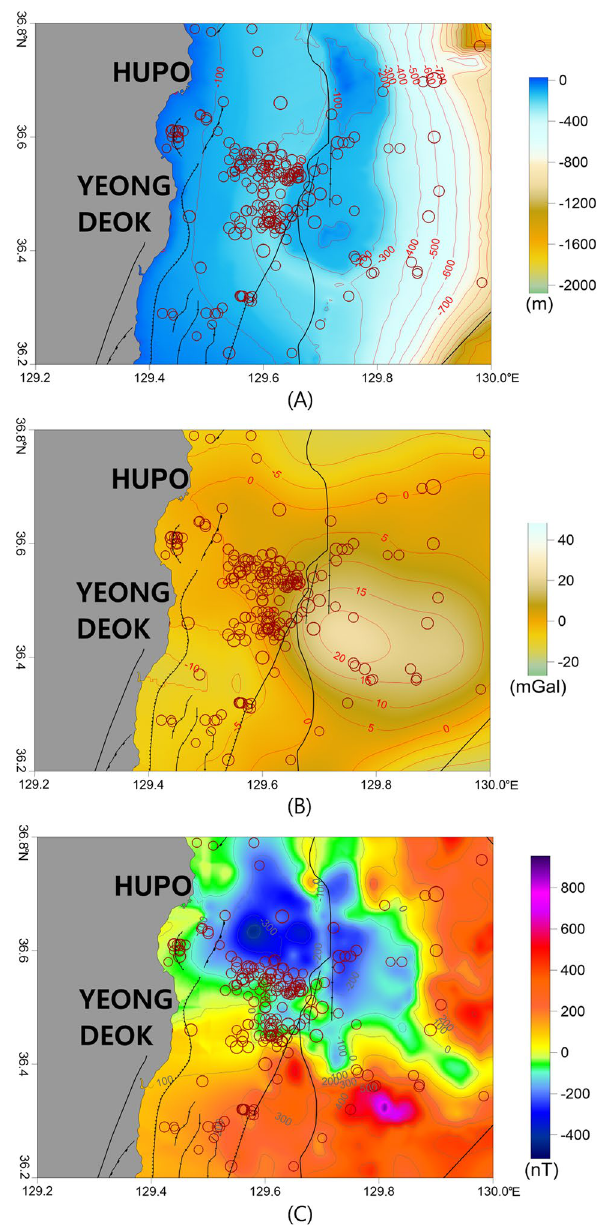
Figure 9. ( A ) Bathymetry map, ( B ) isostasy gravity anomaly map, and ( C ) RTP magnetic anomaly map of the southern area of Hupo Bank. These major geologic structures and symbols of the earthquakes are the same as those in Fig. 2. The figures were generated using the surfer Software (https:// www. golde nsoft ware.